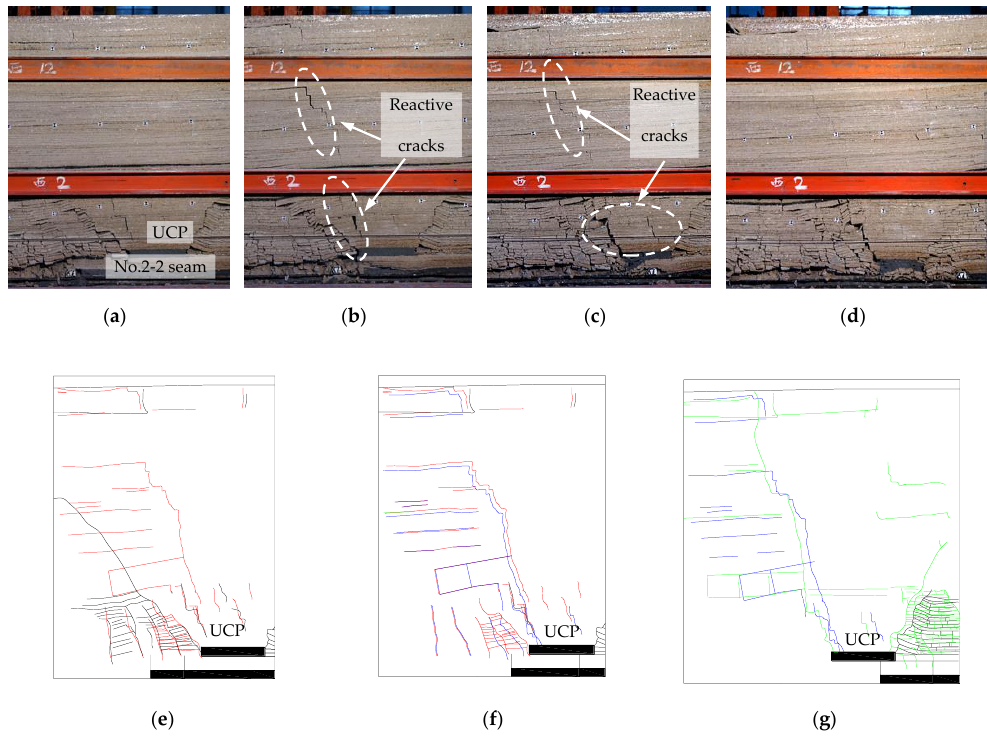
Figure 13. CPC activation schematic diagram: ( a ) 20 m from the UCP left side, ( b ) 10 m from the UCP left side, ( c ) before 10 m from the UCP right side, ( d ) behind 20 m from the UCP right side, ( e ) comparative positions ( a , b ), ( f ) comparative positions ( b , c ), ( g ) comparative positions ( c , d ).